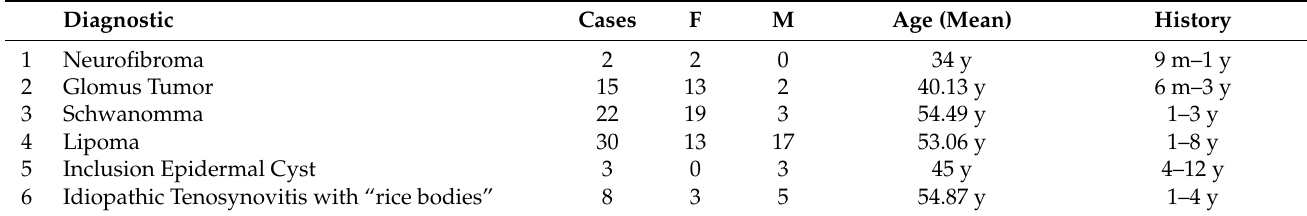
Figure 1. Types of soft tissue tumors diagnosed in the study group. The epidemiological data and tumor history are listed in Table 1. Table 1. Epidemiological factors and history of the tumors in the study group.